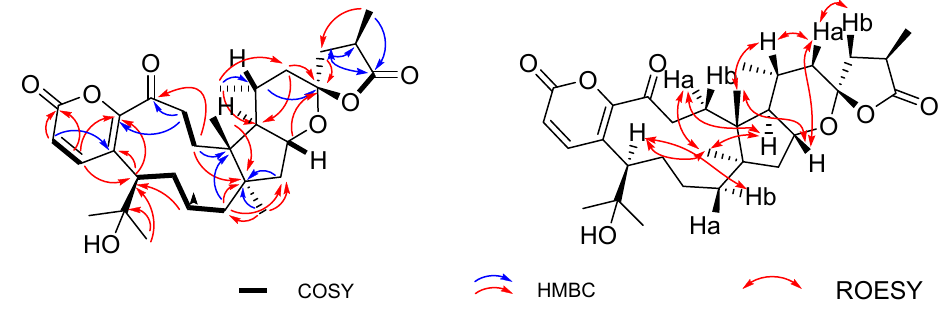
Figure 3. Key COSY, HMBC, and ROESY correlations for compound 2 .